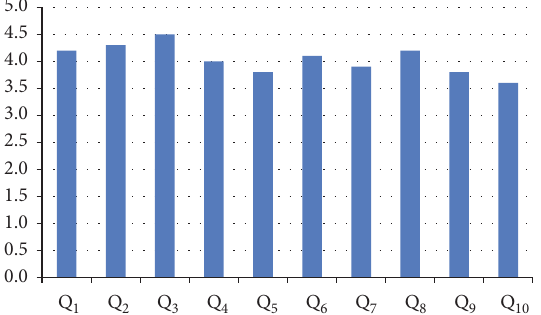
Figure 28: The average score of statements in Table 8 answered by participants to measure